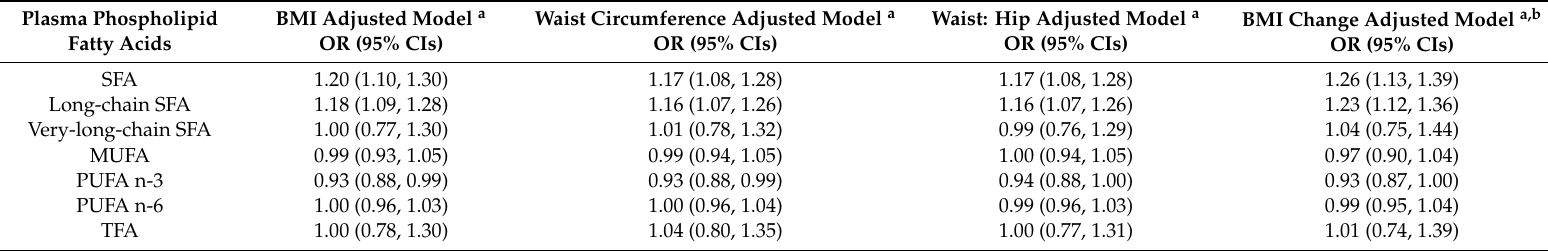
Table A3. Associations (1 moL %) between plasma phospholipid fatty acids and CHD risk when adjusting for di ff erent anthropometric measures in the matched case-control study ( N =